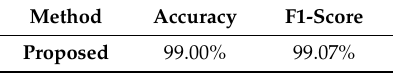
Table 2. Performance measure indicators of the proposed approach.